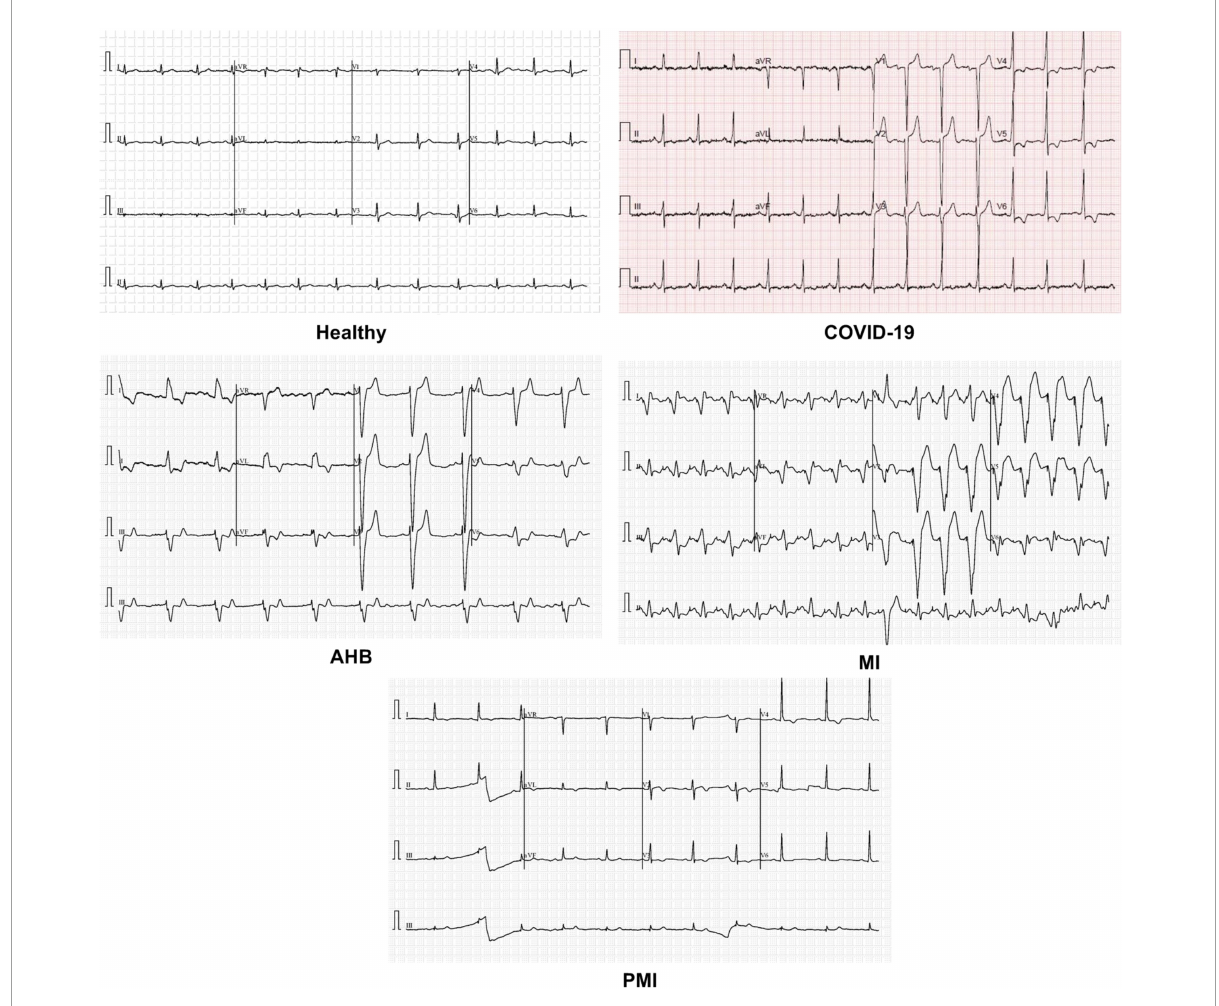
FIGURE2 Sample images of all